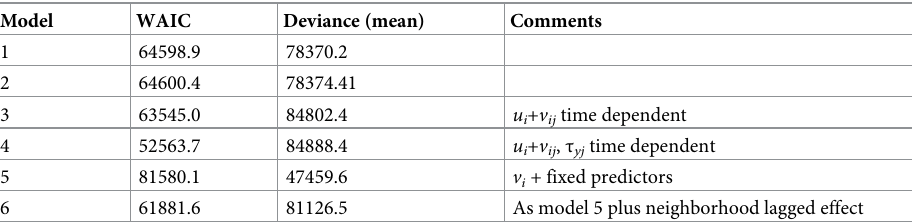
Table 8. New Jersey smoothed data